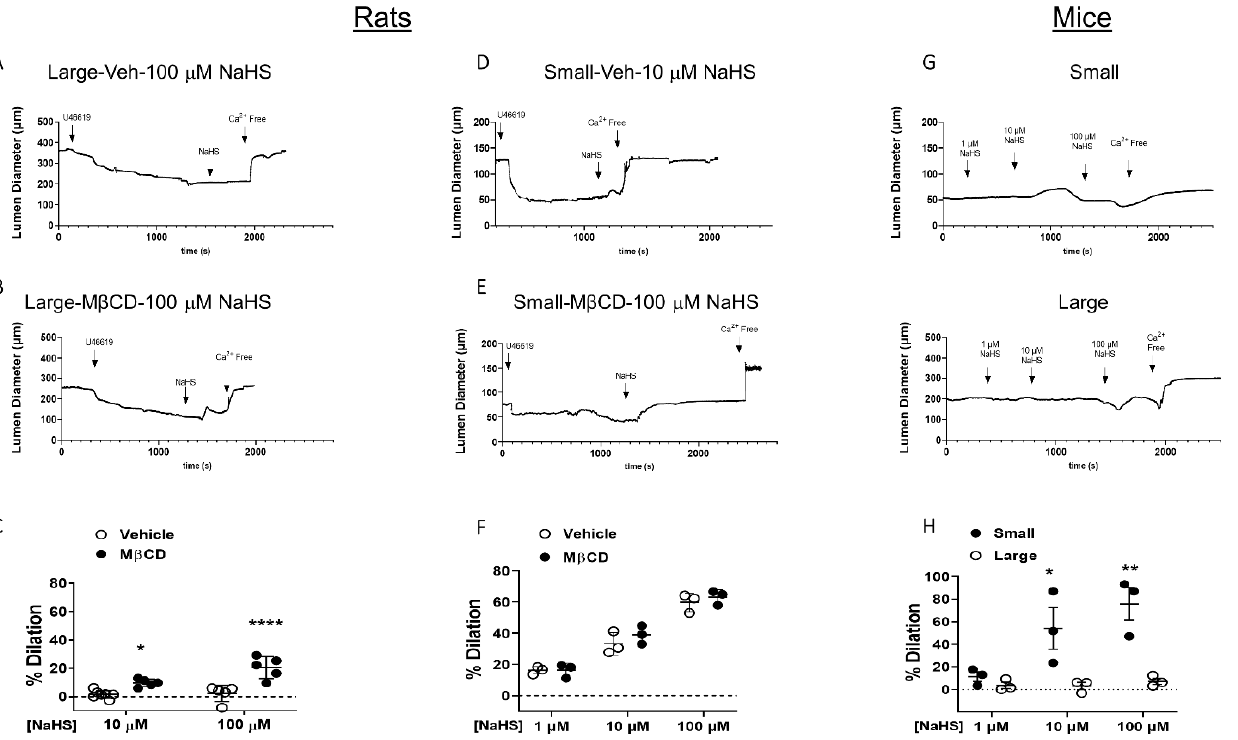
Figure 1. H 2 S-induced vasodilation in rat and mouse mesenteric arteries. Representative traces and data summary of H 2 S-induced vasodilation following cholesterol reduction with M β CD (100 µ M) in rat large arteries ( A – C ). Mean ± S.D. * p = 0.026 vs. vehicle; **** p < 0.0001 vs. vehicle and rat small